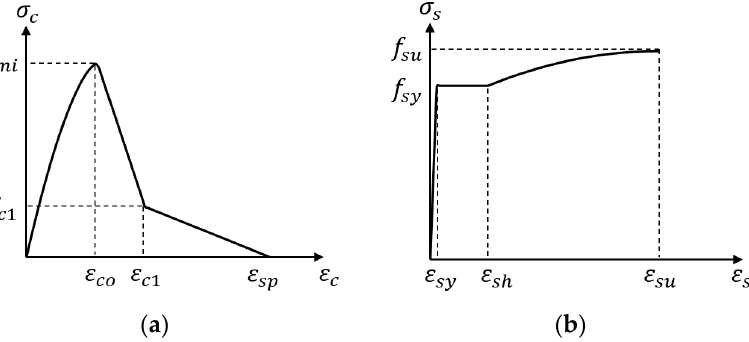
Figure 8. Material models for non-linear moment–curvature analysis of lightly reinforced precast